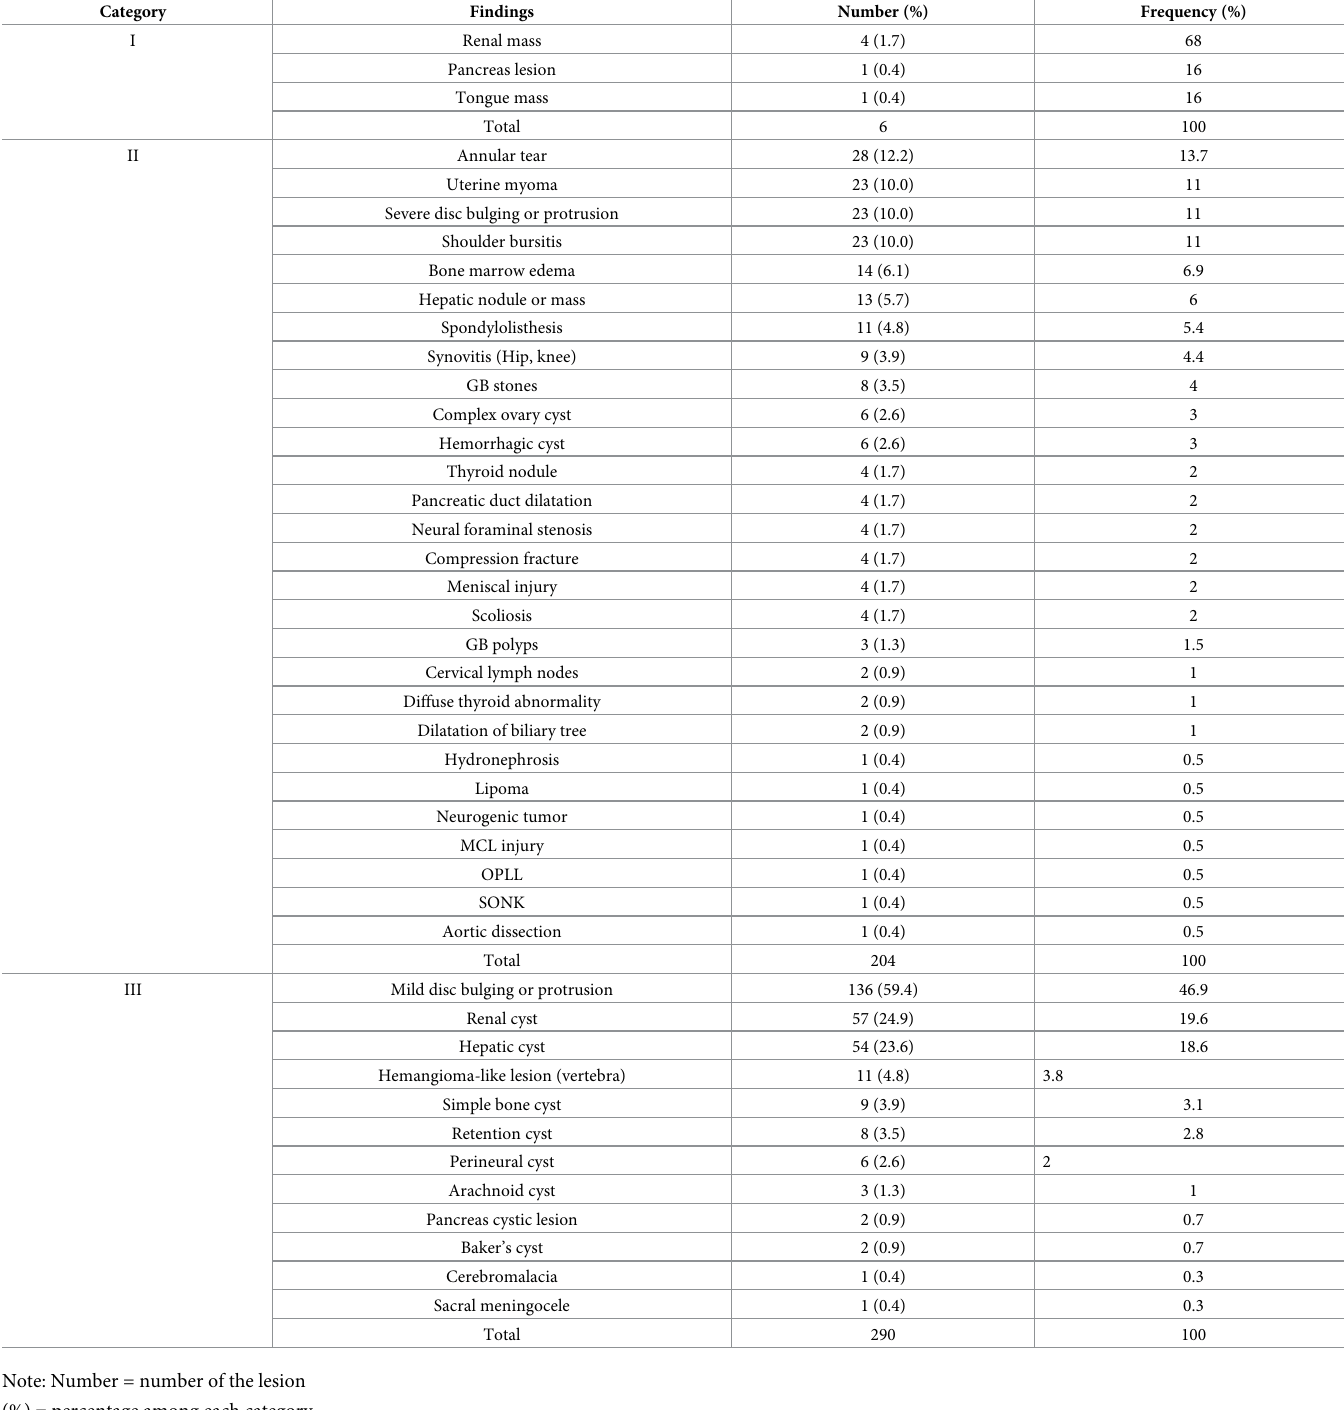
Table 4. Incidence of positive findings by category (n = 500).